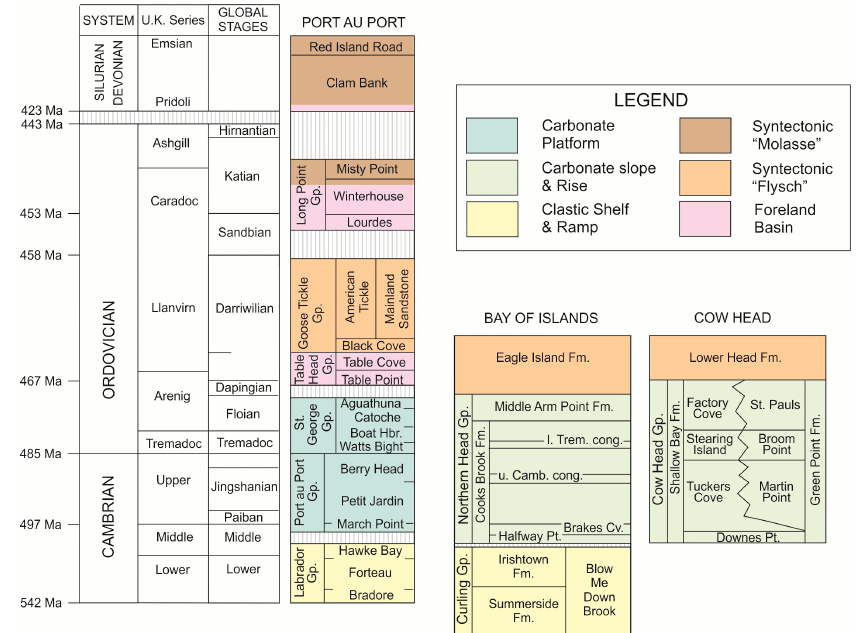
Figure 2. Modified and simplified regional tectonostratigraphy and correlations for Lower Paleozoic sedimentary rocks in the western Newfoundland (adapted from